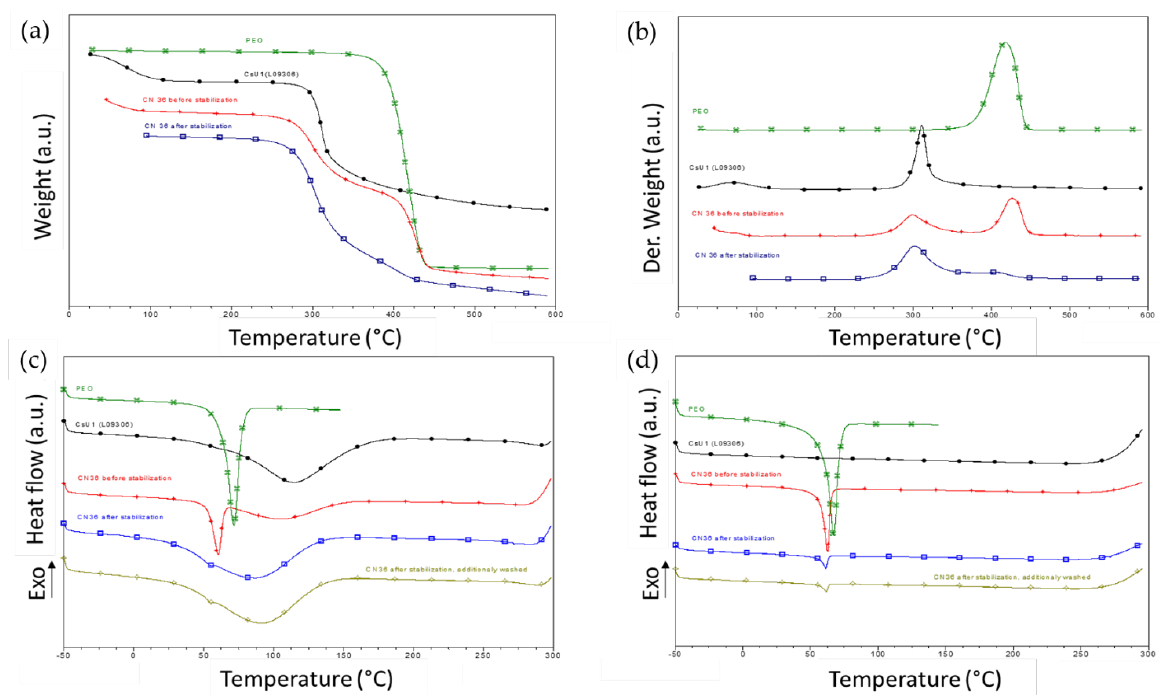
Figure 4. Thermal behavior of CsU1 (black traces), PEO (green curves), CN36 mat before (red traces) and after stabilization and purification (blue traces and grey traces after additional washing). TGA curves ( a ) and TGA derivatives ( b ); DSC curves first ( c ) and second ( d ) heating ramps.